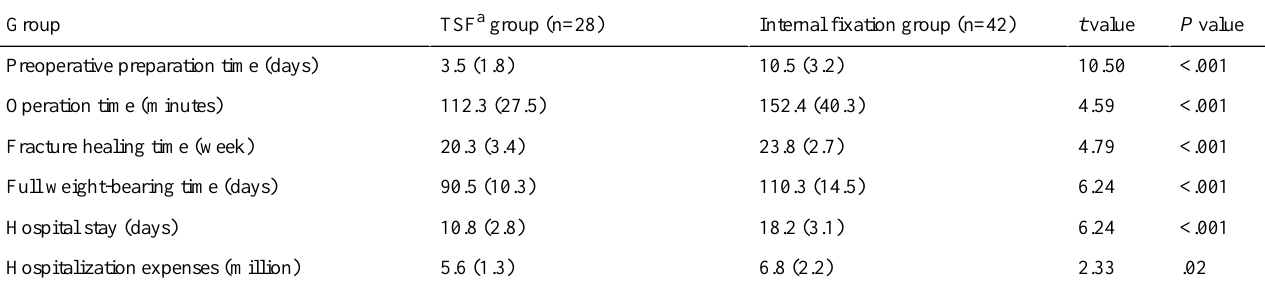
Table 1. Comparison of surgical-related indicators between the two groups ( ).